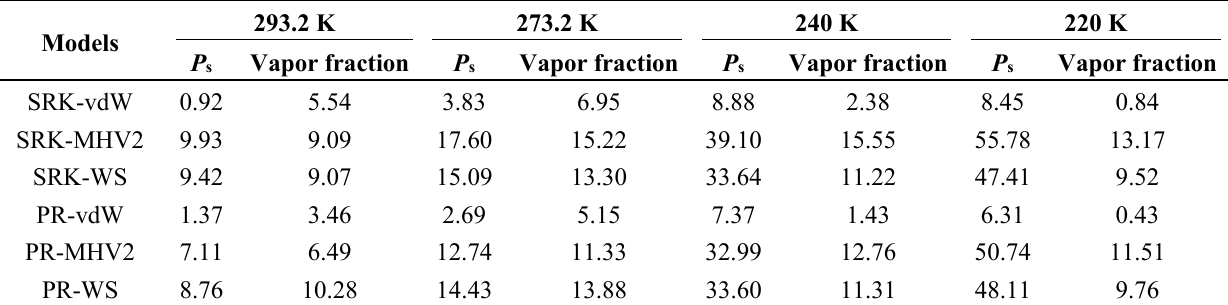
Table 3. Average relative deviation between calculated results and experimental data (%).